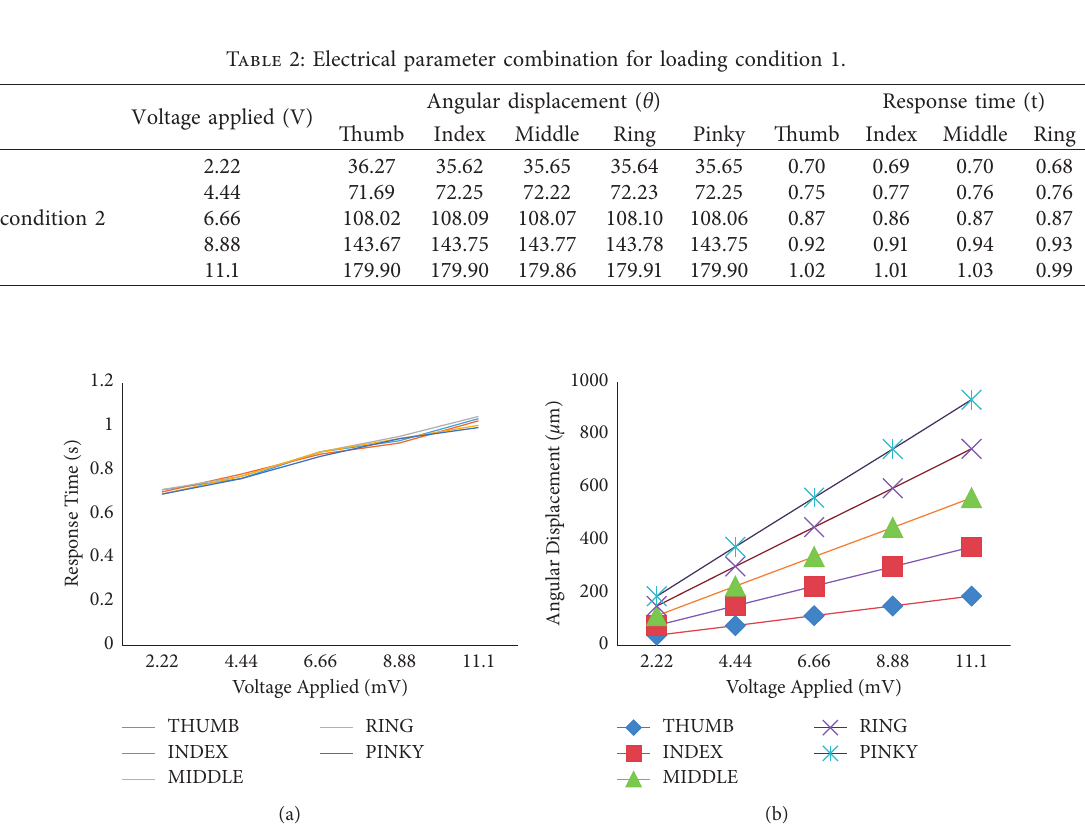
Figure 8: (a) Plot of angular displacement against voltage for LC1 and (b) plot of response time against voltage for loading condition 1.